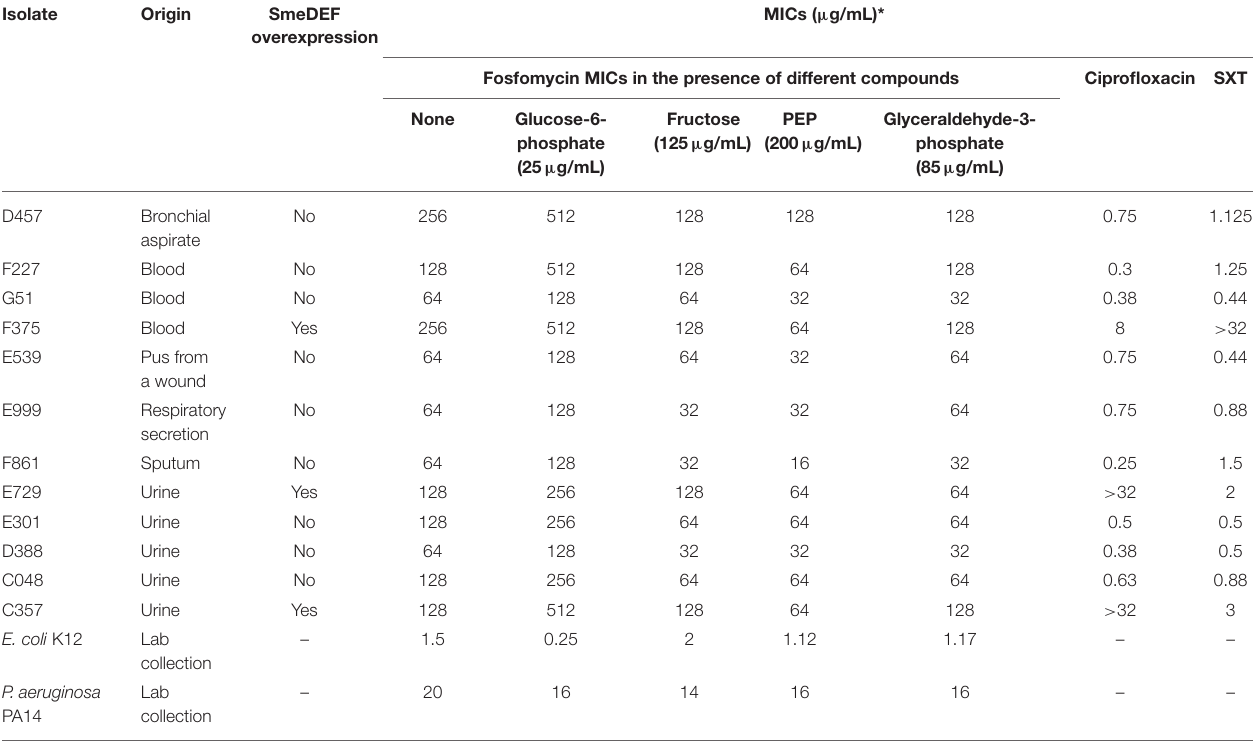
TABLE 1 | Susceptibility of S. maltophilia , E. coli, and P. aeruginosa to antibiotics in the presence of potential fosfomycin adjuvants.